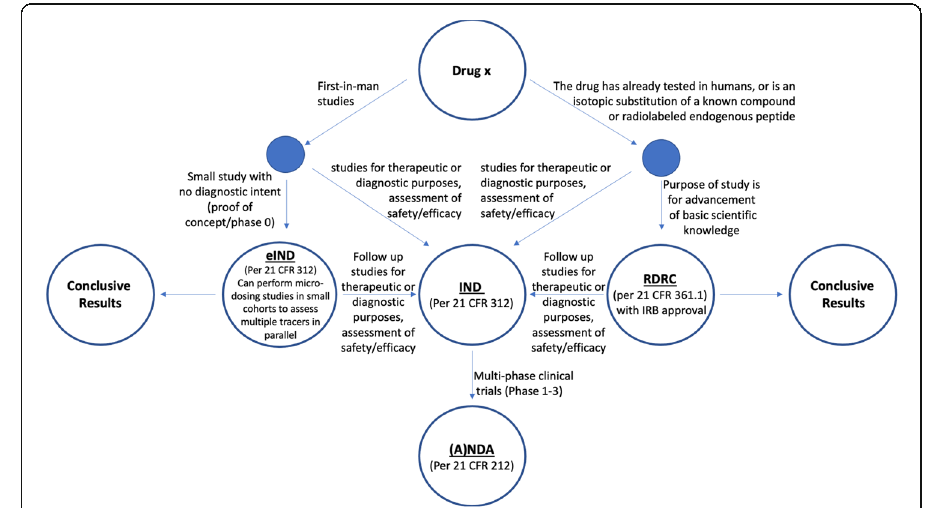
Fig. 1 Regulatory Oversight for PET Drugs in the United